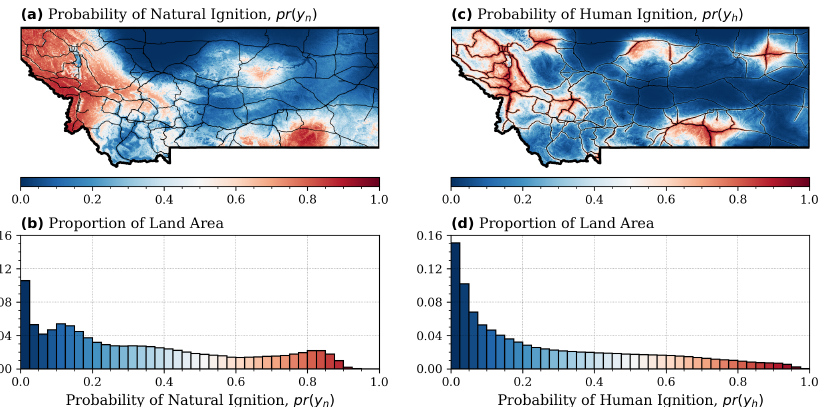
Figure 9. Maps of ( a ) the probability of a naturally ignited wildfire, pr ( y n ) , and ( c ) the probability of a human-caused wildfire, pr ( y h ) , in Montana obtained from the spatial-GAMs. Distributions of the proportion of land area as functions of pr ( y n ) and pr ( y h ) are shown in ( b ) and ( d ),